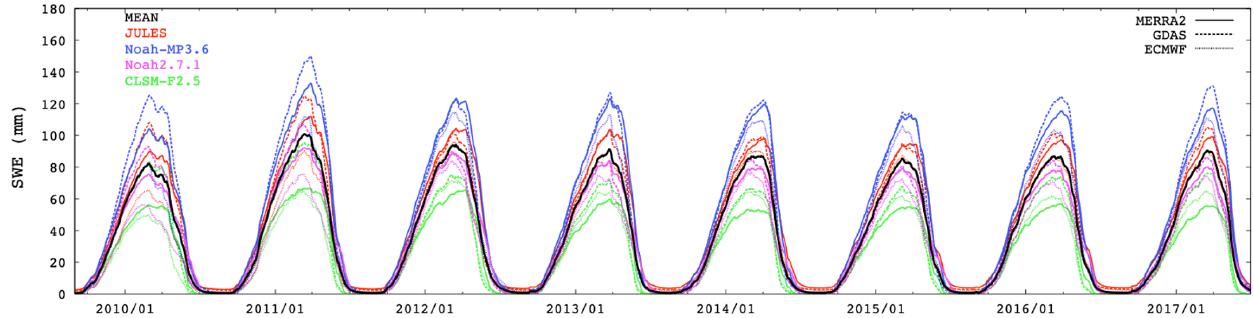
Figure 5. Time series of domain-averaged mean SWE. Different colors and line style were used to represent each ensemble; a bold black solid line represents the domain-averaged ensemble mean; the units are